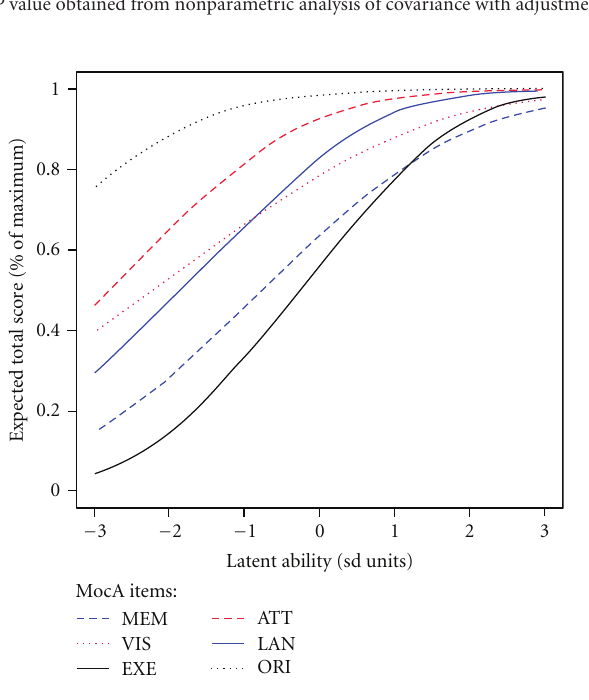
Figure 6: Test characteristic curves (TCCs) for the MoCA-ChLA domain scores in the total sample MEM: short-term memory; VIS: visuospatial construction; EXE: executive function; ATT: attention and concentration; LAN: language; ORI: temporal and spatial orientation.